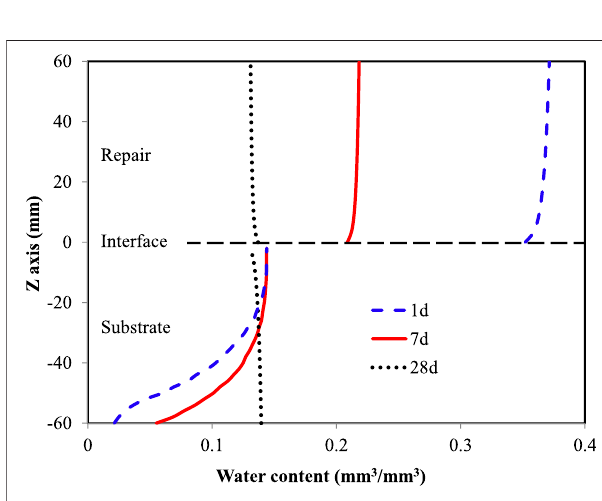
FIGURE 9 | Simulated water content in the concrete substrate at 2, 4 and 6 h after placing the repair material. FIGURE 10 | Change in the water content of the repair material and the